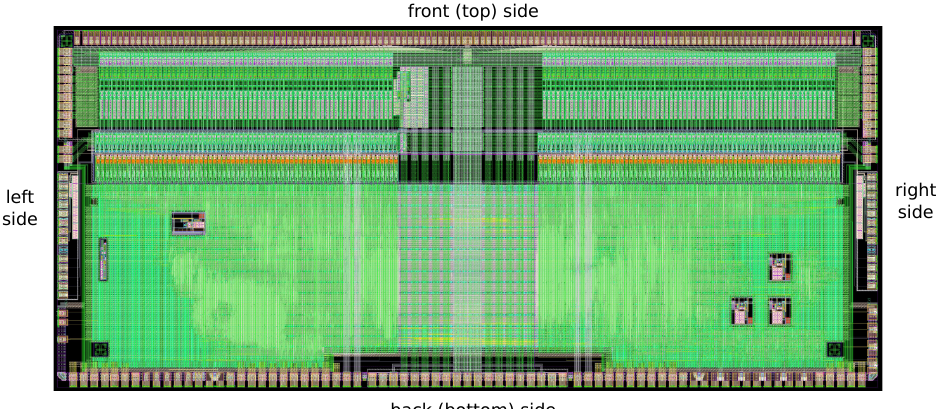
Figure 8. Layout of SALT ASIC; the die size is 10.905mm ×